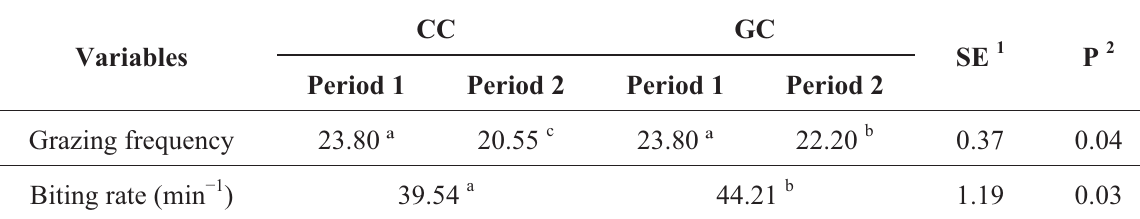
Table 4. Grazing frequency (5 min interval) in two observation periods (Period 1, from 8 to 10 am; Period 2, from 10 am to 12 pm) and average biting rate of cows given either commercial concentrate (CC) or ground corn